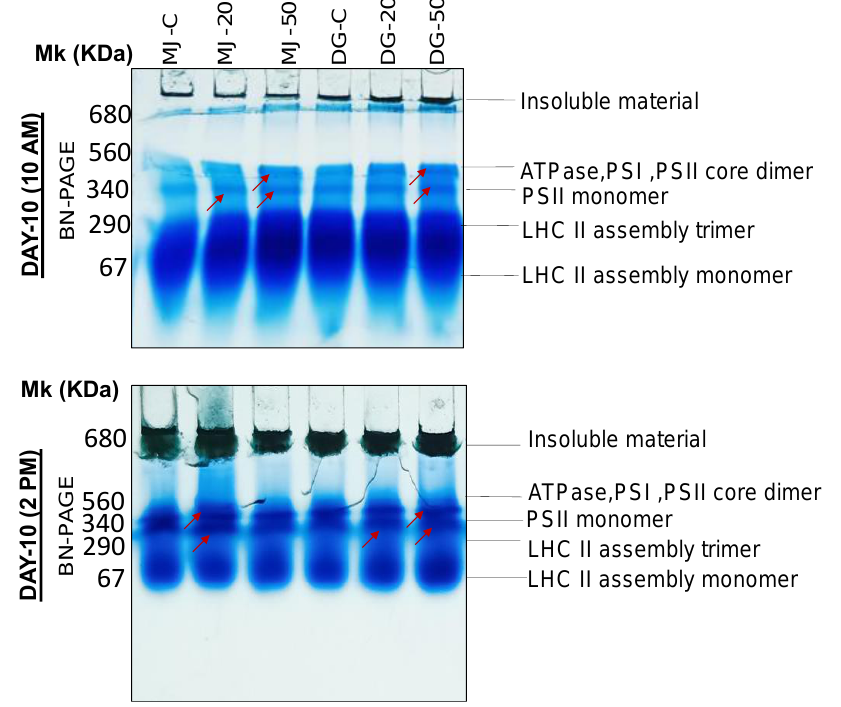
Figure 12. First dimension BN-PAGE in spinach genotypes Delhi green (DG) and Malav Jyoti (MJ). Results are presented for the controls (MJ control; DG control), 20 mM of NaCl treatments (MJ-20 mM; DG-20 mM), and 50 mM of NaCl treatments (MJ-50 mM; DG-50 mM). Sampling was performed (on the basis of the circadian cycle) at 4 h intervals which corresponded to the exact times of 10 am, and 2 pm of day 10 of salinity stress. For first dimension BN-PAGE, fresh thylakoid membranes of both spinach genotypes were solubilized in 1% BDM at a chlorophyll concentration of 1µg·µL−1, and the protein sample was separated by 7% – 12.5% gradient BN-PAGE. For second dimension gels, slices were horizontally laid on top of 12.5% SDS-PAGE and stained with a commercial Coomassie brilliant blue R-250 (Bio-Rad, Hercules, CA, USA). The arrows in the gel indicate the changes in expression of protein bands compared with their respective controls.